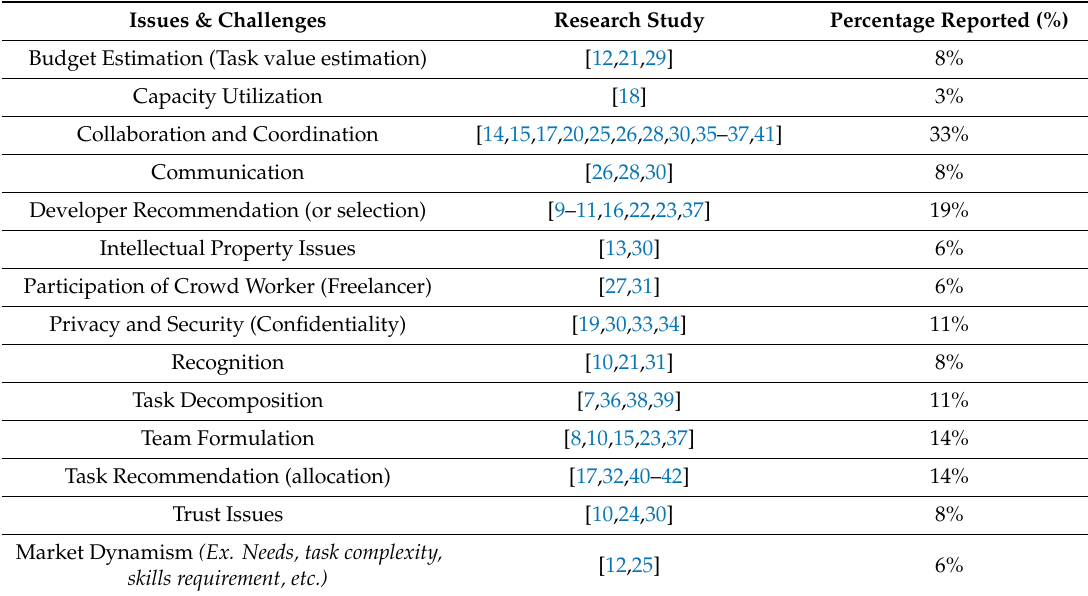
Table 6. Patterns of research issues and